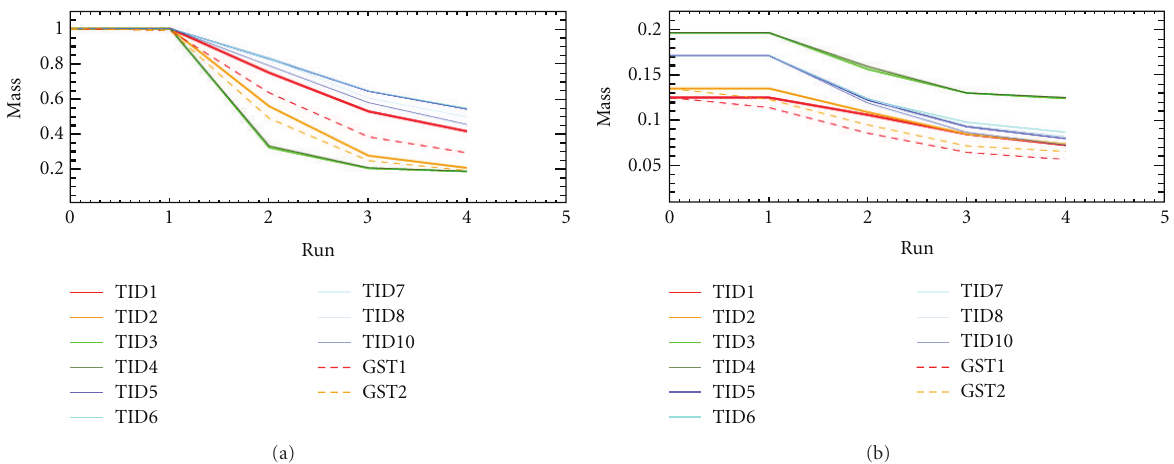
Figure 22: Change of total (a) and luminous (b) mass of simulated galaxies after di ff erent fast tidal events (see details in [289]). by bright Es and bulges of early-type galaxies. In contrast, galaxies with initially small B/D ratios are located at the position of the dwarf galaxies in the face-on view of the FP. These simulations show that dE and dS0 galaxies can be formed by the tidal disruption of late-type spirals. In contrast, the tidal disruption of early-type galaxies would produce a final galaxy similar to elliptical or S0 galaxies.